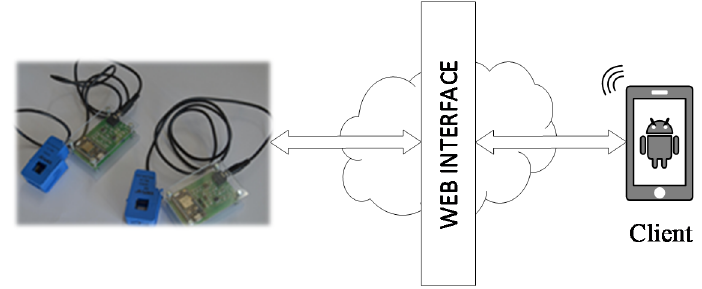
Figure 8. The web interface used to access the published data.